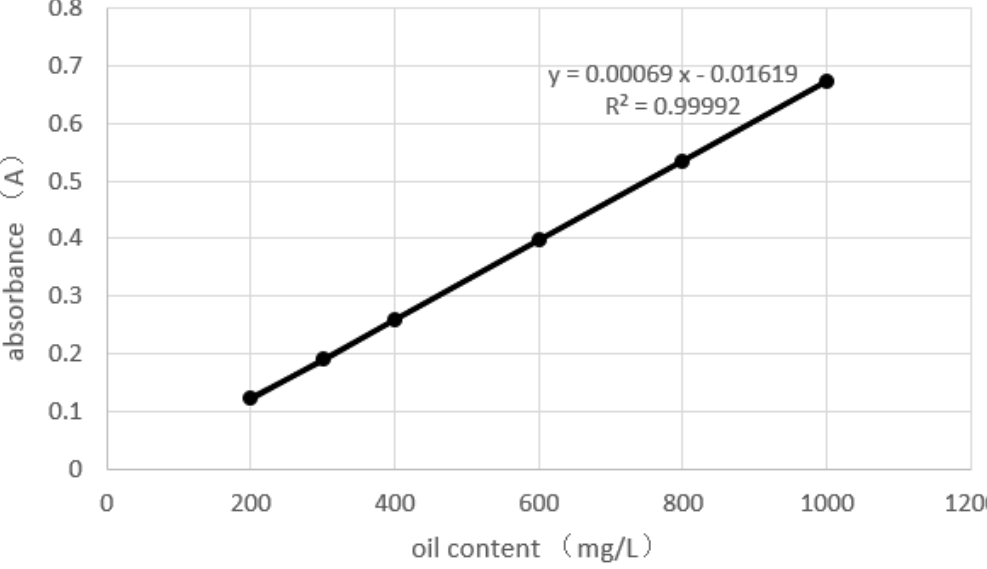
Figure 2. The relationship between absorbance and oil content.